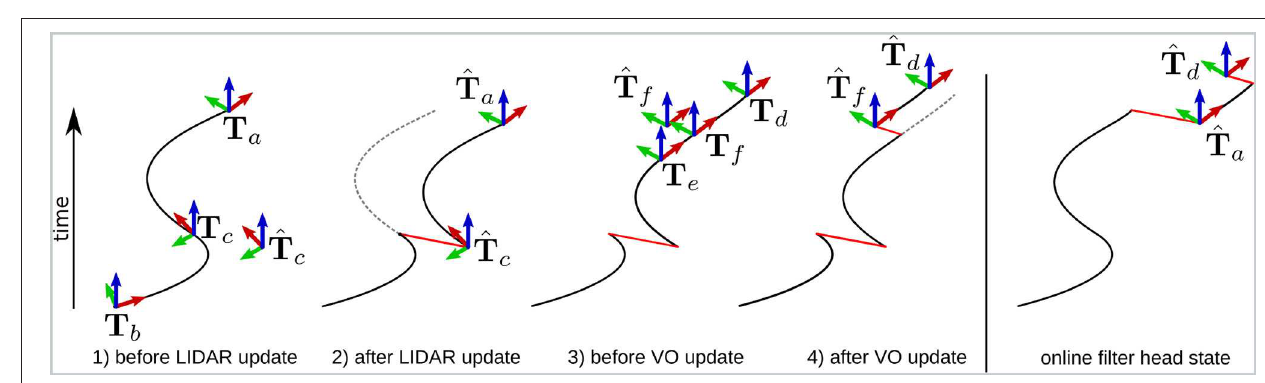
FIGURE 6 | Example illustrating how VO and LIDAR measurements can be incorporated into the filter despite having much higher latency than the IMU process model. In black is the best estimate of the trajectory at that instant, in red are updates introduced by incorporated measurements, and dashed gray lines are parts of the trajectory that are recomputed. For clarity, the magnitude of the corrections is exaggerated. Elapsed time is indicated in the upward direction.